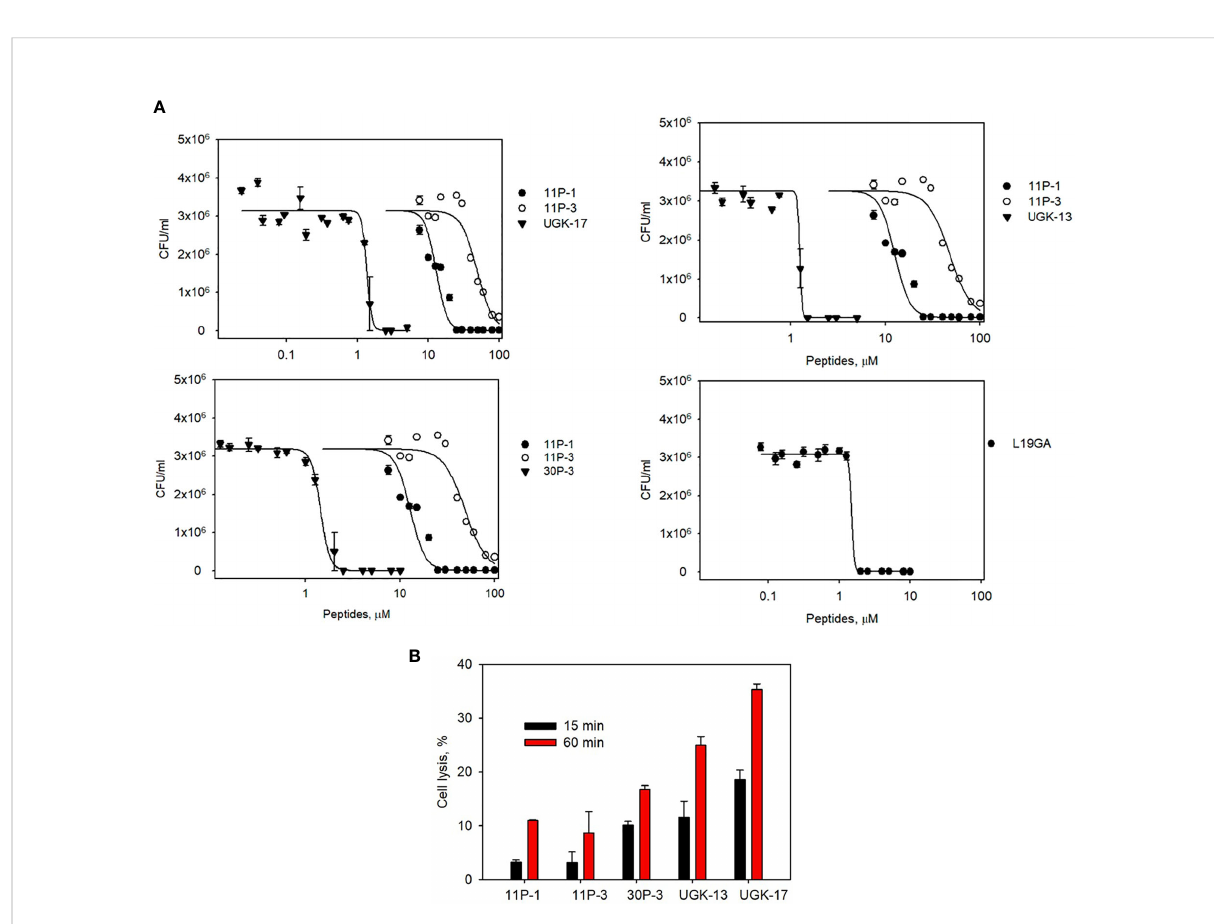
FIGURE 1 (A) Bioluminescence data of the viability of Escherichia coli BL21 at different peptide doses for the a / b chimeras UGK-13, UGK-17, and 30P-3. Also shown are the dose – response curves for the single-unit constituents of the chimeras, i.e., 11P-1 and 11P-3, and the dose – response curves for L19GA with two b -strands stabilized by two S – S bridges. E coli BL21 cells (5 × 10 5 cfu)were incubated with peptides for 24 h. (B) Bacterial cell lysis by the different peptides was measured using the luciferase assay. Bacterial cell death was observed by the lysis of E coli BL21 (pACYC184-nLuc) cells upon incubation with corresponding antibacterial peptides by measuring the luciferase activity in the cell-free supernatants at 15 min and 1 h